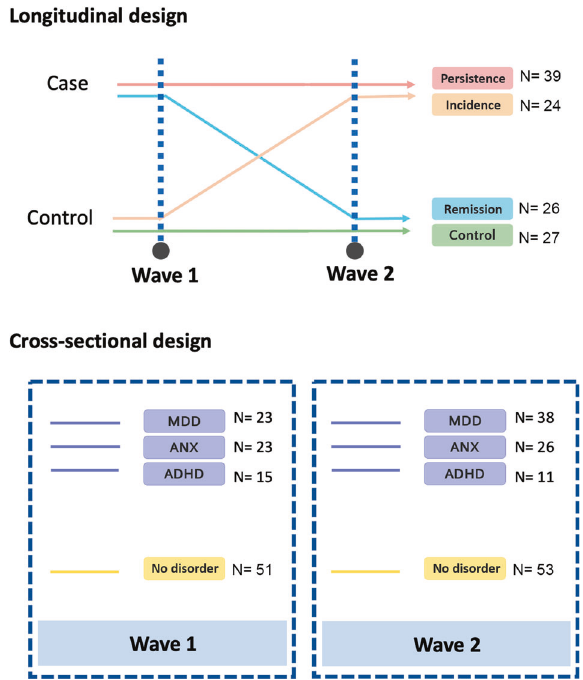
Fig. 1 Schematic of the study design, illustrating the longitudinal and cross-sectional approaches. Longitudinal design: the dotted blue lines represent the two analyzed time points, Wave 1 and Wave 2. The colored horizontal linesrepresent the differences in case – control status between both time points,which was the criteria to de fi ne each trajectory group. Sample sizes for each group are also included. Cross-sectional design: the dotted blue lines represent each of the two time points that were analysed separately in this design. Inside each box, sample sizes for each considered disorder (MDD, ANX andADHD), as well as the no disorder group, are shown.